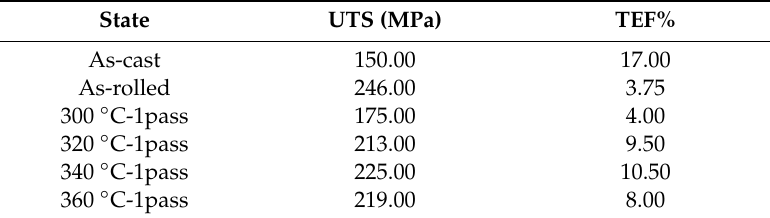
Table 3. The mechanical properties of the samples.